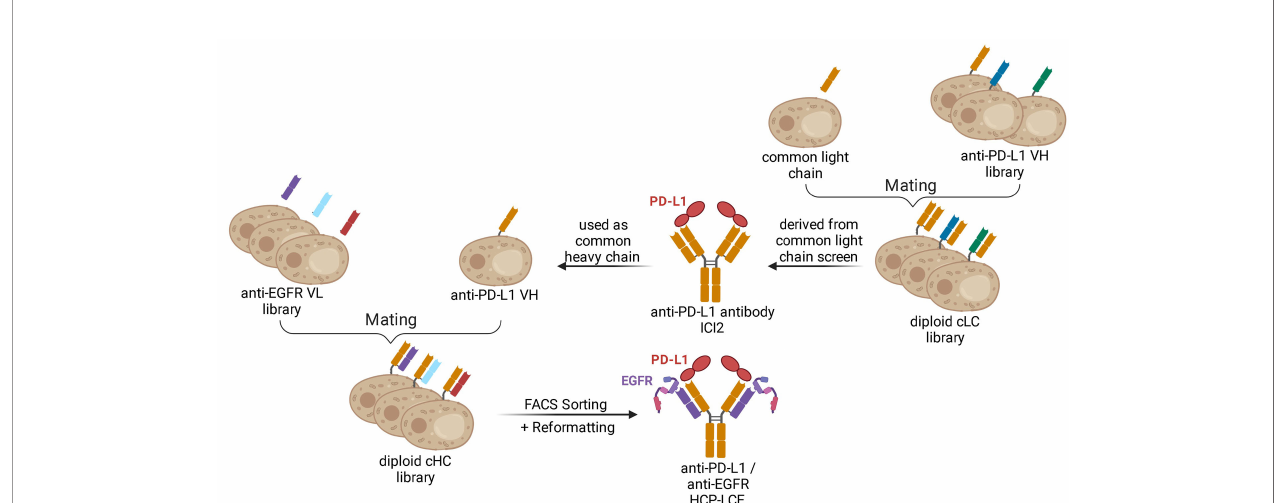
FIGURE 1 | Schematic representation demonstrating the generation of the Two-in-One antibody HCP-LCE. The anti-PD-L1 antibody ICI2 is derived from a common light chain YSD library. The VH fragment of the anti-PD-L1 antibody ICI2 was paired with an anti-EGFR VL library by yeast mating. FACS screening and subsequent reformatting into the full-length antibody format enabled the isolation and production of a Two ‐ in ‐ One antibody targeting PD ‐ L1 and EGFR. Created with